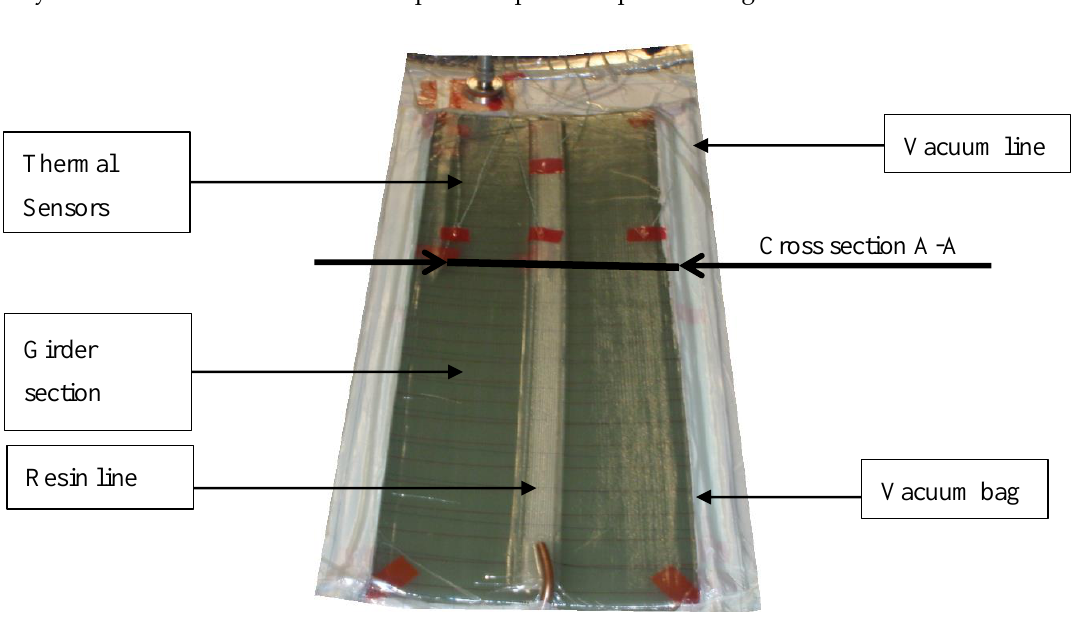
Figure 5. Infusion set-up for girder sections.